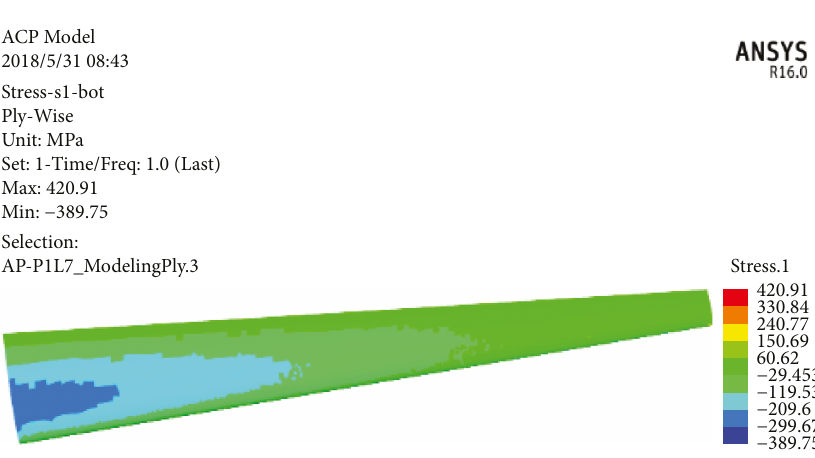
Figure 33: Stress cloud diagram of the upper wing with the layer angle being 90 and